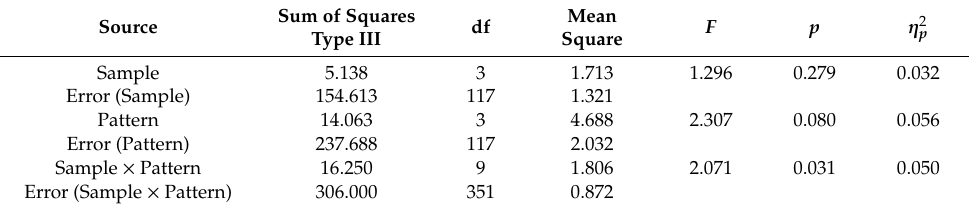
Table 9. Results of four-way mixed ANOVA for stability (Test result of within subject e ff